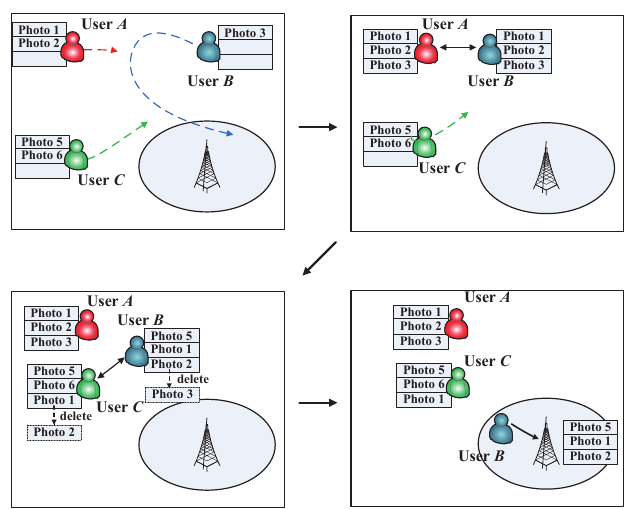
Figure 2. A running example of the storage management problem in mobile phones for photo crowdsensing. User A with photos 1 and 2 encounters user B with photos 3; they exchange photos in the epidemic manner. After a period of time, user B encounters user C ; they exchange photos and delete the photo with the lowest utility when the storage is overflowed. Finally, when user B enters a PoI, it uploads all the photos